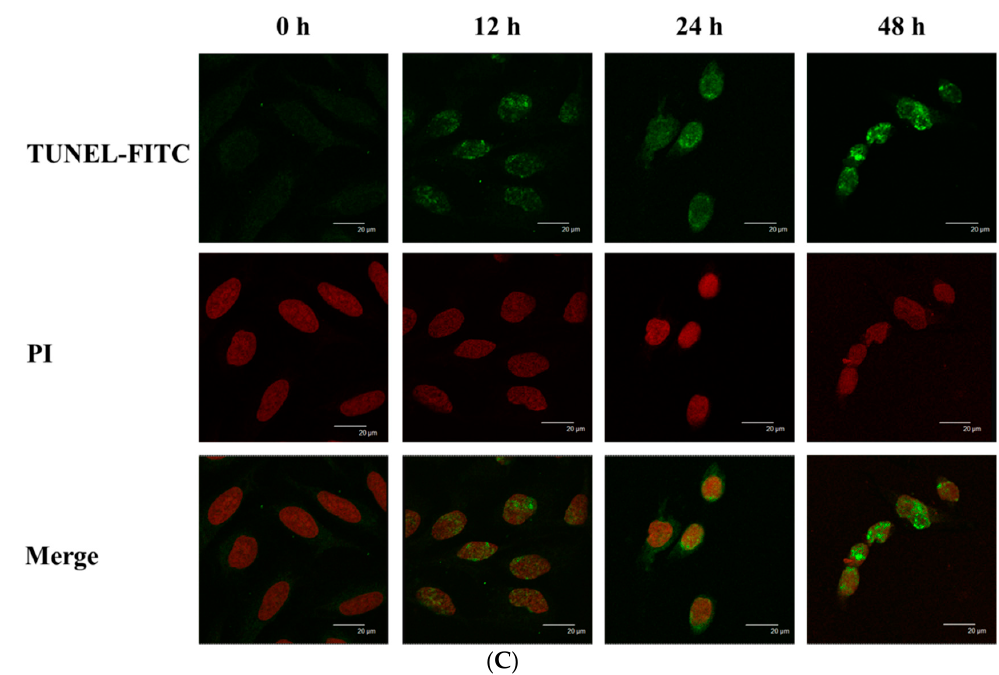
Figure 3. Bufalin induced apoptosis of U-2 OS cells. Cells were treated with 200 nM of bufalin for 0, 12, 24, and 48 h before the cells were ( A , B ) double stained using Annexin V/PI and were analyzed by flow cytometry or ( C ) were assayed for TUNNEL assay, as described in Materials and Methods. * p < 0.05, significant difference between bufalin-treated groups and the control as analyzed by Student’s t test.